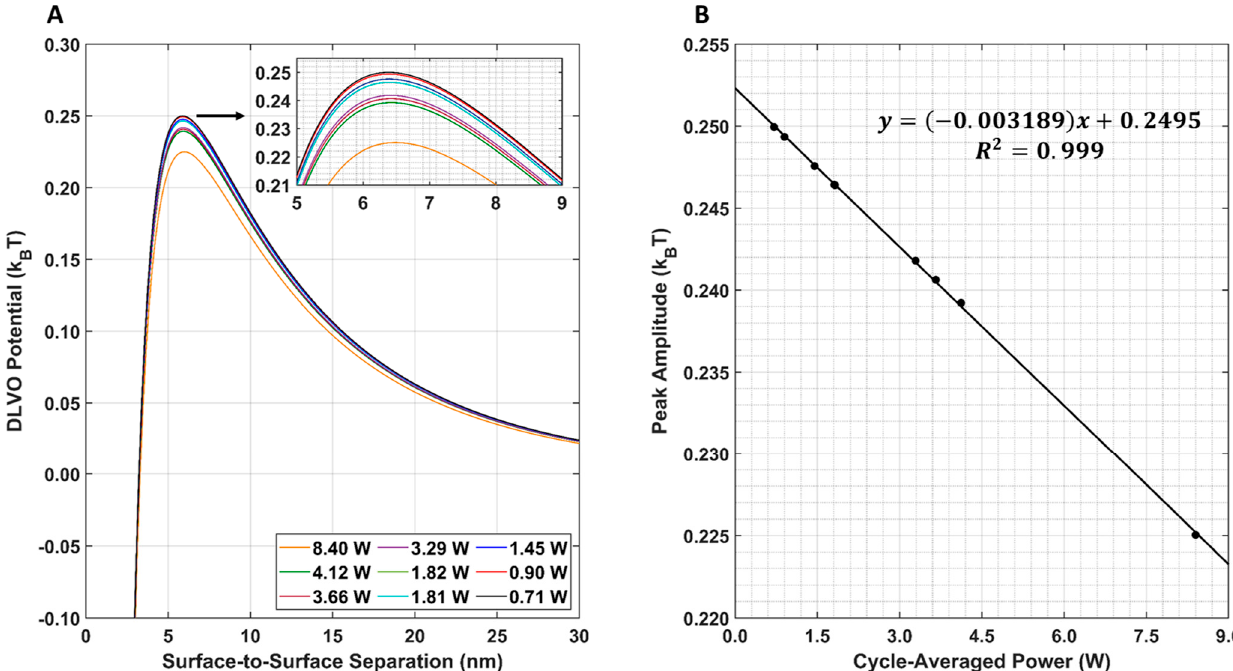
Figure 8. ( A ) DLVO total interaction potential for all nine LIPUS settings. An inset shows peak differences; ( B ) DLVO total interaction potential maximum peak amplitude for all nine LIPUS settings. A linear fit was applied to the data. The R 2 value of the fit is also provided for reference.